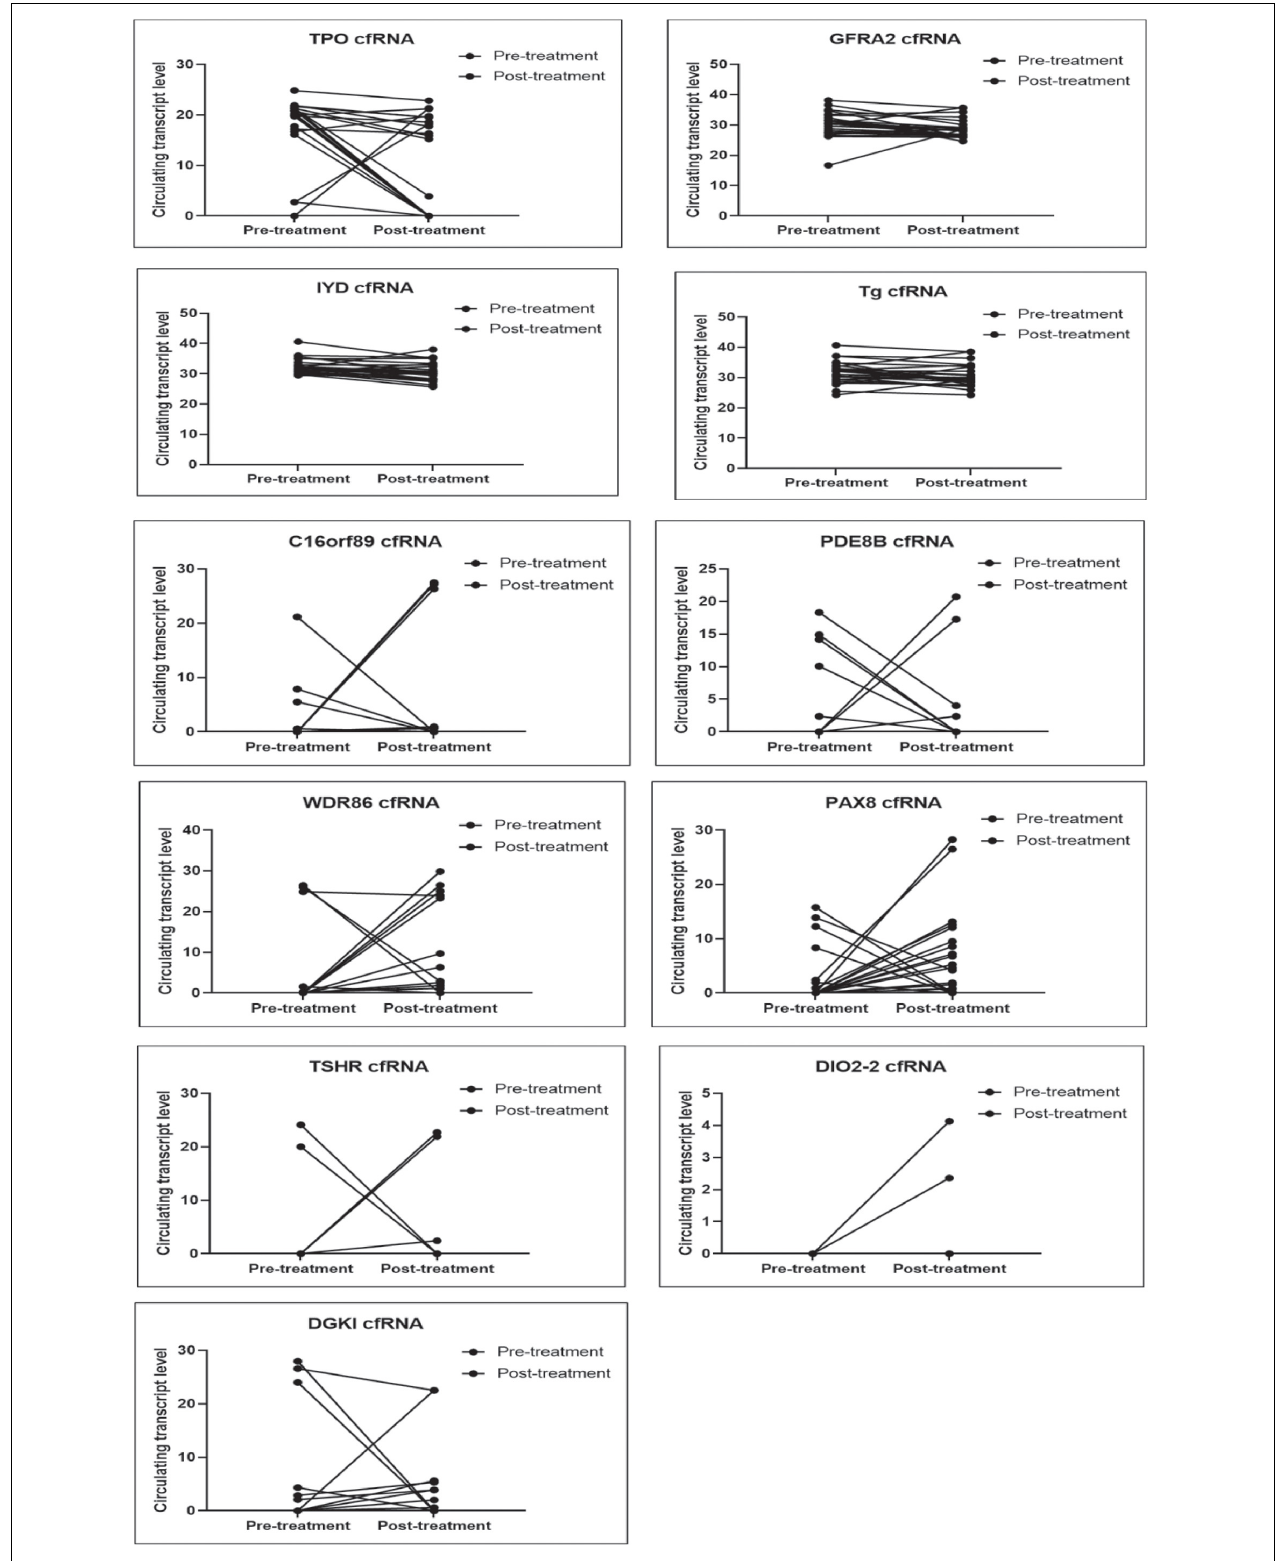
FIGURE 3 | Plots comparing pre- and post- treatment levels of thyroid-specific cfRNA transcripts candidates. The circulating cfRNA levels plotted along Y-axis were derived from 60- Ct values.